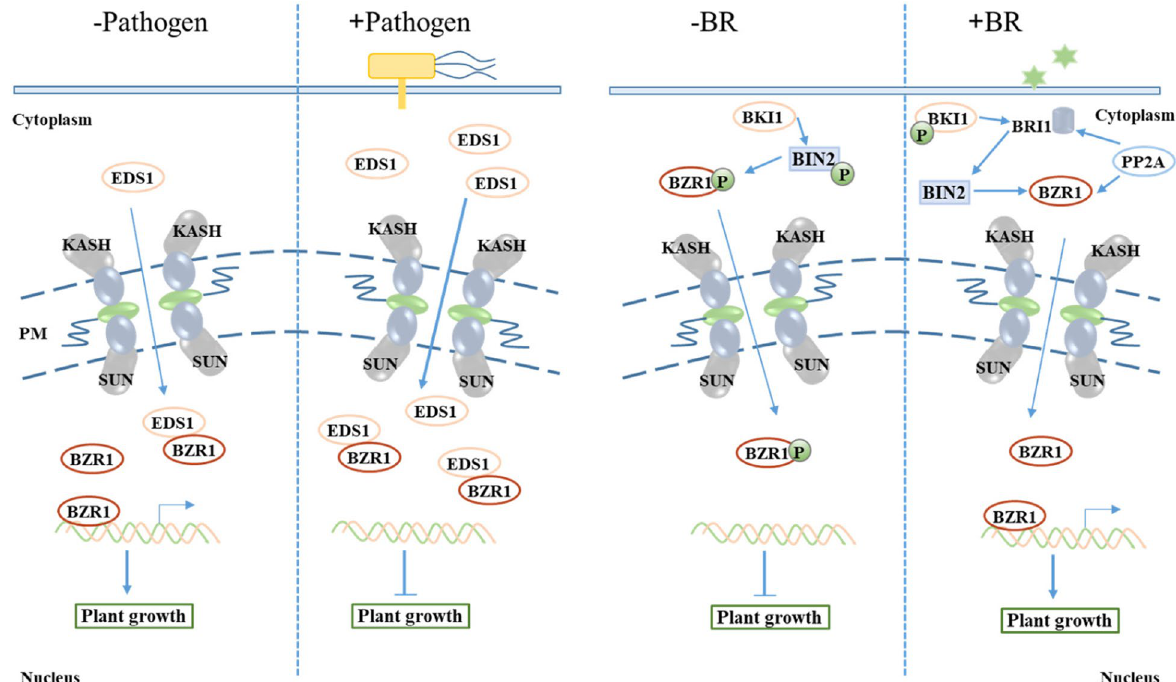
Fig. 2 Diagram depicting nucleocytoplasmic transport and transcription factor BZR1 coordination tradeoffs in regulating development and defense gene expression. The cell wall is indicated in a simplified format with blue bar. Note that nuclear envelope channel components interact with each other in manners that are too complex and manifold to detailed display. The effector classes were given on the top based on the stimulated factors. The regulation mechanism of NPC in functional genes was simulated in the middle and bottom panel, including nucleocytoplasmic shuttle and competitor/decoy (transcript factors (TFs) binding targets/protein inhibitors or phosphorylation inactivation). The coiled double lines represent the regulated gene by TFs, like BZR1, and the latter could be dephosphorylated by PP2A. The outline and shapes of NPC components and the tethered regulators are purely schematic; their size have no meaning. The regulated genes could be any potentially functional gene, including development-related genes, R genes and their regulator (e.g. transcription and splicing